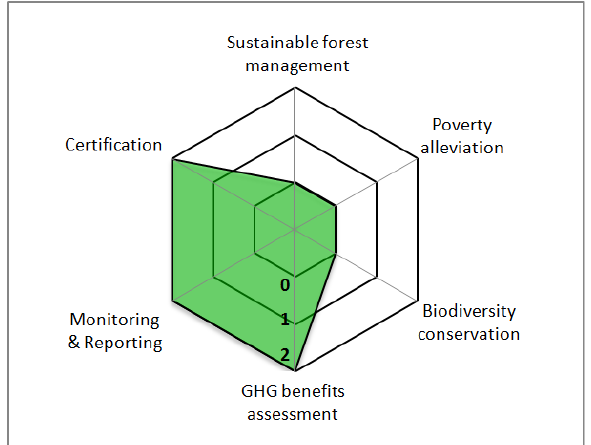
Figure 10. Summary of Voluntary Carbon